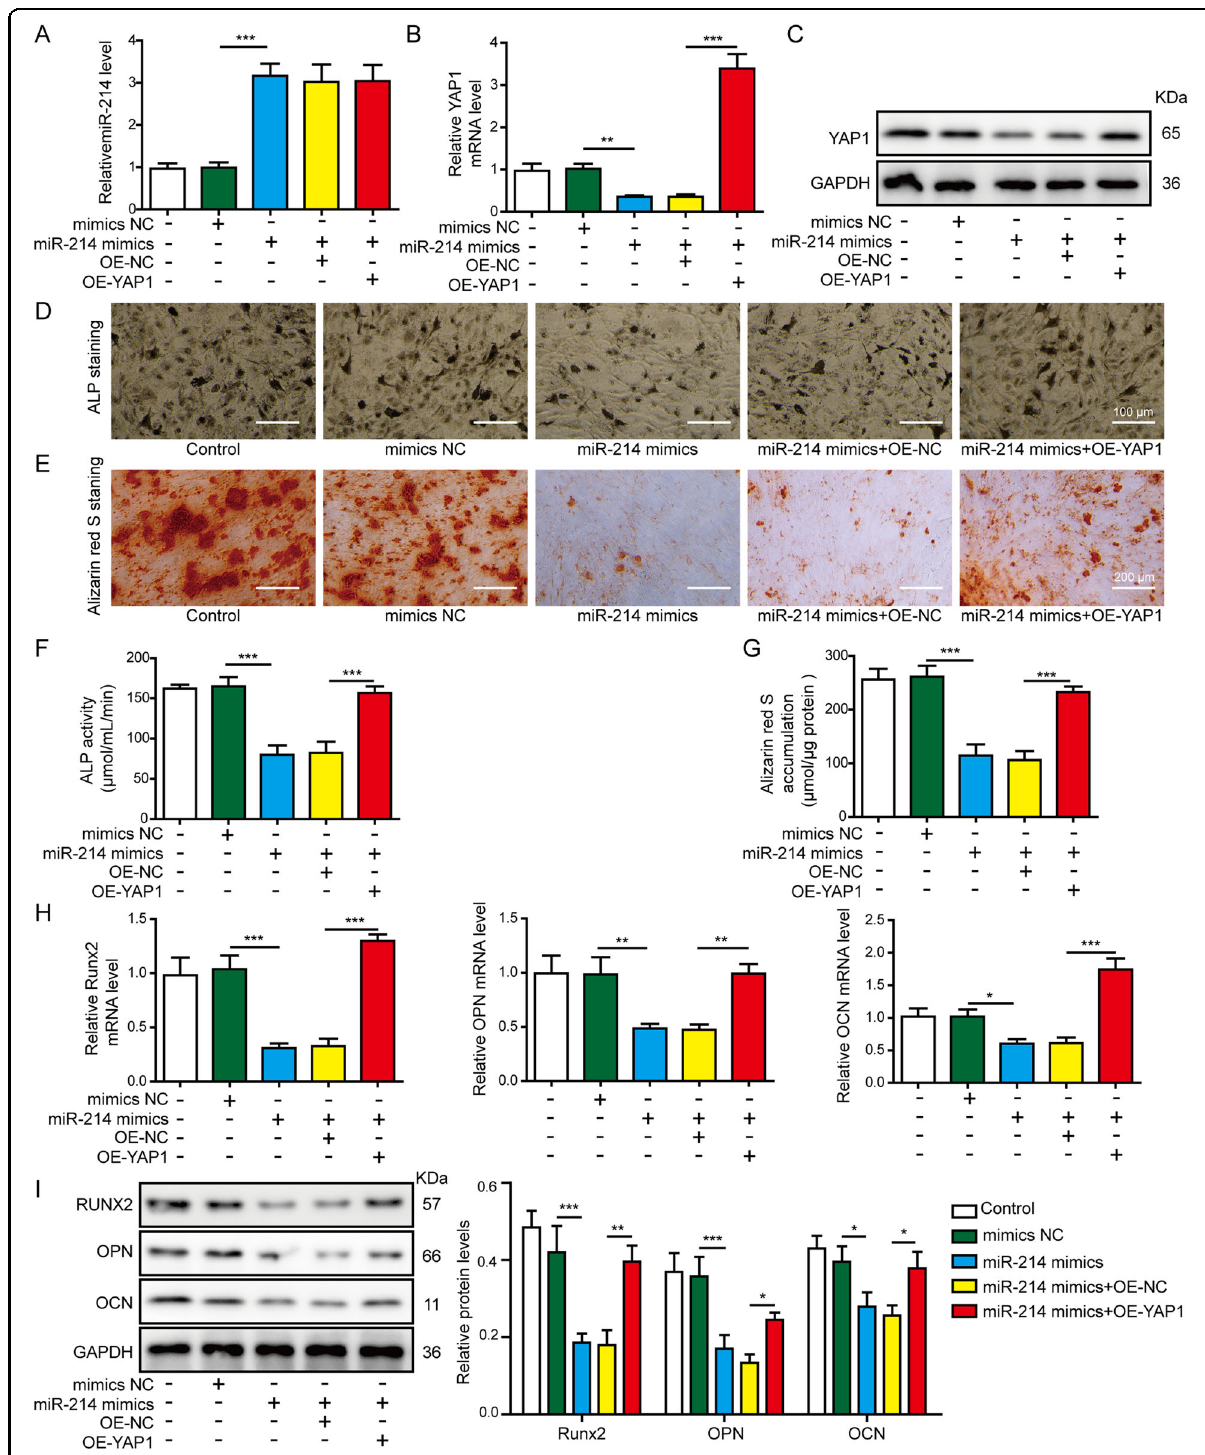
Fig. 6 YAP1 reversed the effects of miR-214 overexpression on osteogenic differentiation of hBMSCs. The hBMSCs were transfected with miR- 214 mimics alone or co-transfected with miR-214 mimics and OE-YAP1. A , B RT-qPCR analyses of miR-214 and YAP1 expression in hBMSCs. C The protein expression level of YAP1 in hBMSCs was assessed by western blot assay. D ALP staining detection was performed on day 14 after osteogenic differentiation. Scale bar: 100 μ m. E Alizarin red S staining detection was performed to indicate calci fi cation on day 14 of osteogenic differentiation. Scale bar: 200 μ m. F ALP activity detection was performed on day 14 after osteogenic differentiation. G Alizarin red S quanti fi cation was performed to indicate calci fi cation on day 14 of osteogenic differentiation. H , I The mRNA and protein expression levels of RUNX2, OPN, and OCN was assessed by RT-qPCR and western blot assays on day 14 after osteogenic differentiation. * P < 0.05, ** P < 0.01, and *** P <